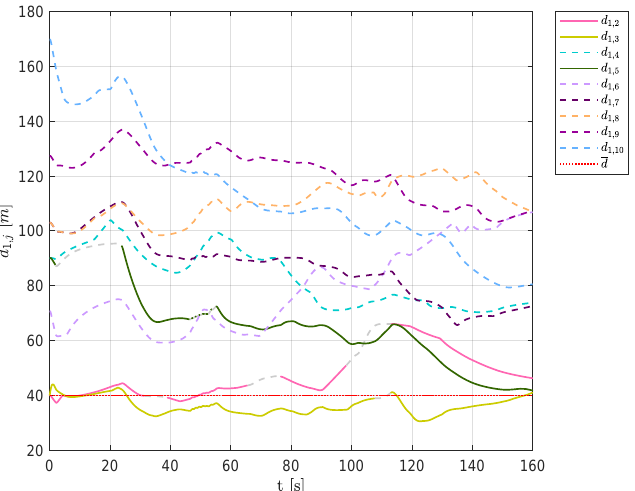
Figure 17. Scenario #1—10 aircraft: distances between UAV 1 and the other swarm vehicles. Solid lines are used for visible aircraft and dashed gray lines are employed whenever they are no longer visible, whereas dashed colored lines are used for never visible UAVs. The desired distance is highlighted using a dotted red